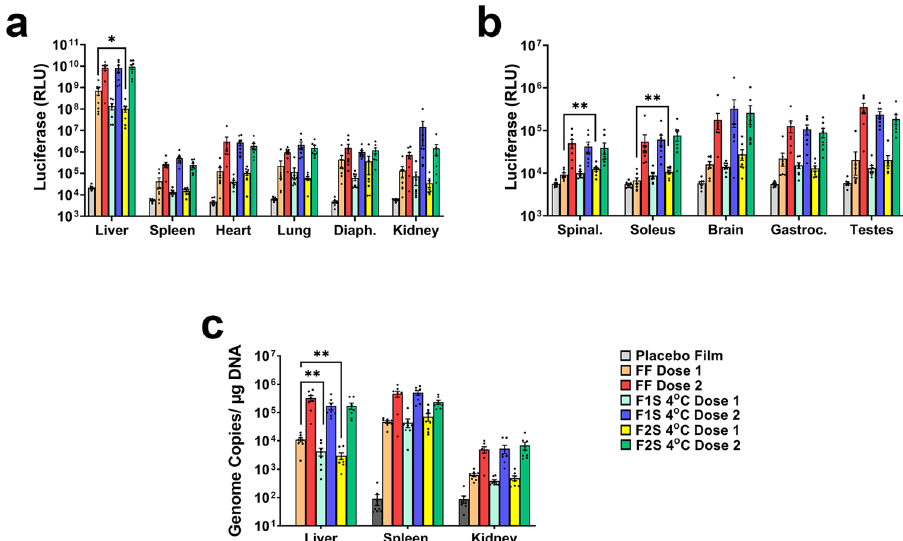
Fig. 7 AAV stabilized in a thin fi lm for 150 days at 4 °C performs in vivo in a dose-dependent manner equivalent to that of a frozen vector. Films prepared with high (F1S) and low (F2S) viscosity formulations were rehydrated and diluted with saline to administer 1 × 10 10 (Dose 1) or 1 × 10 11 (Dose 2) virus genomes of AAV9 CBA-Luc by tail vein injection. a , b Luciferase transgene expression in target organs 30 days after administration assessed by bioluminescence imaging. Mean (±standard error of the mean) values for total fl ux for each organ are shown. Signi fi cant differences between animals treated with each dose of the standard control formulation (FF) and the equivalent dose of FS1 and FS2 formulations were evaluated by one-way ANOVA with Dunnett ’ s multiple comparison tests. c Genome copies of AAV9 in organs with high transgene expression as determined by quantitative real-time PCR. Data re fl ect the mean (±standard error of the mean) values for each treatment group. Signi fi cant differences between subgroups with respect to dose were evaluated by one-way ANOVA with Tukey ’ s multiple comparison tests. a , b Diaph diaphragm, Spinal spinal cord, Gastroc gastrocnemius muscle * p < 0.05, ** p < 0.01.